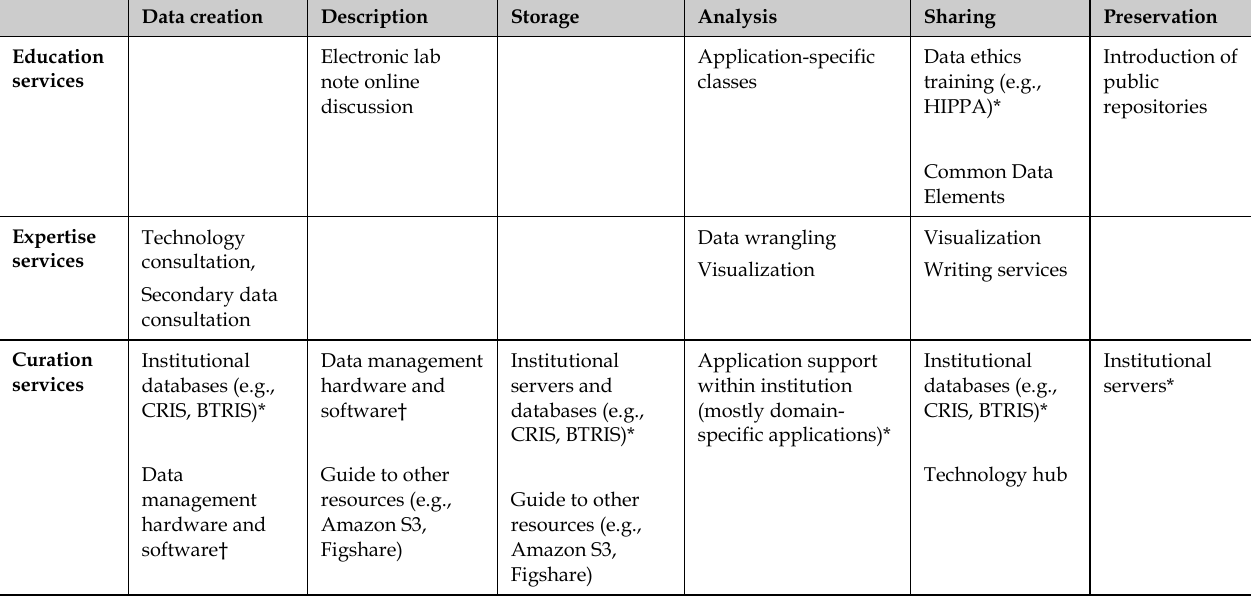
Table 2 NIH’s research data management